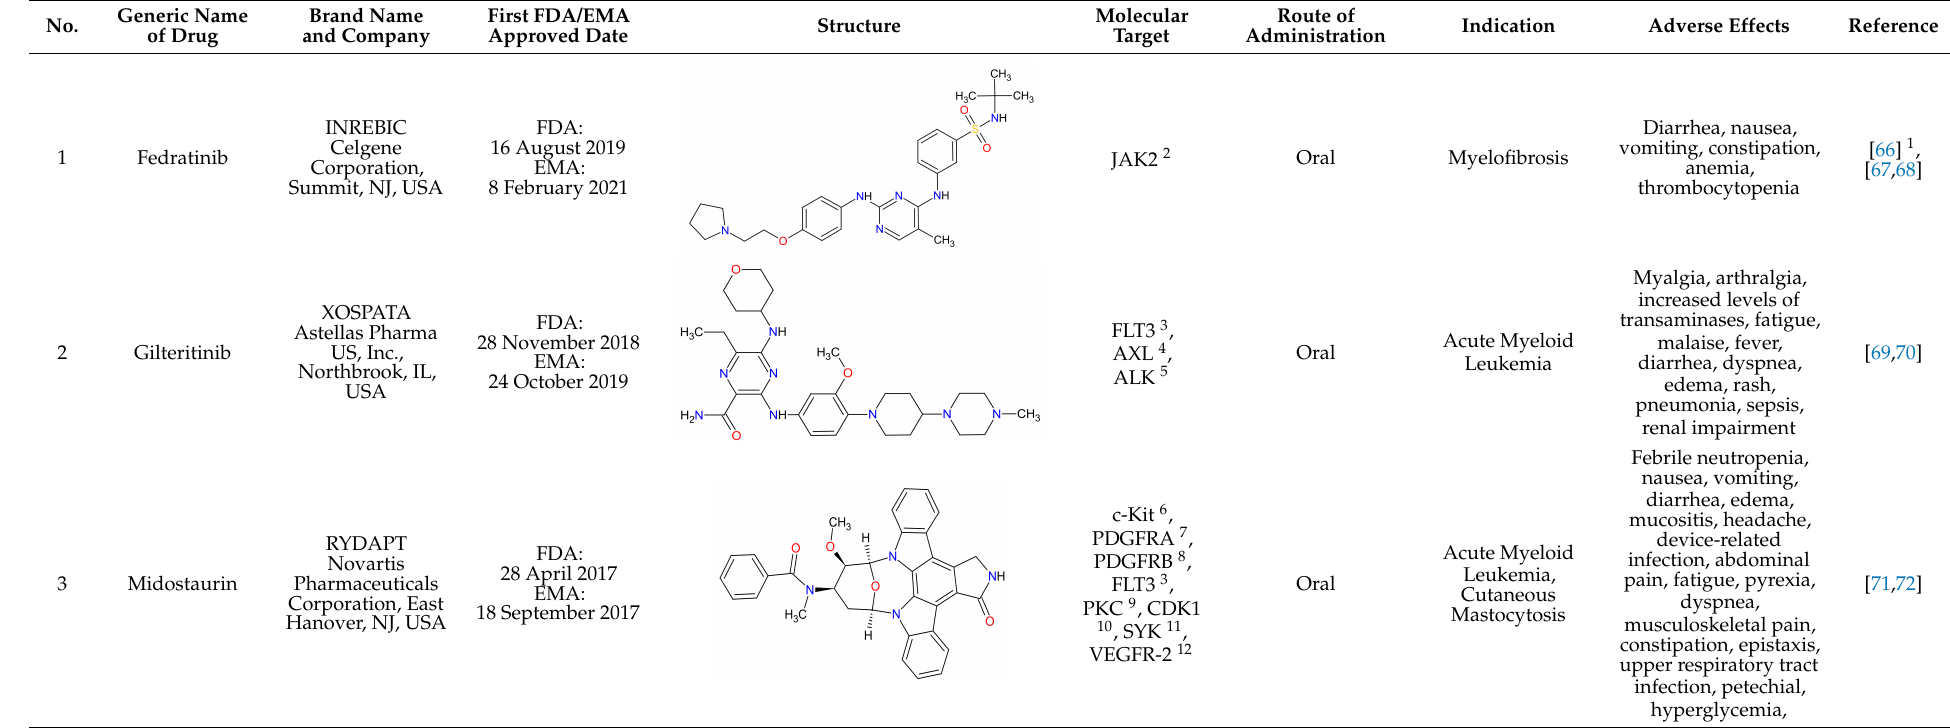
Table 2. Features of the multi kinase inhibitors approved by the Food and Drug Administration (FDA) from 2011 to 2021. The order of drugs is tabulated in order of most recent to the oldest registration